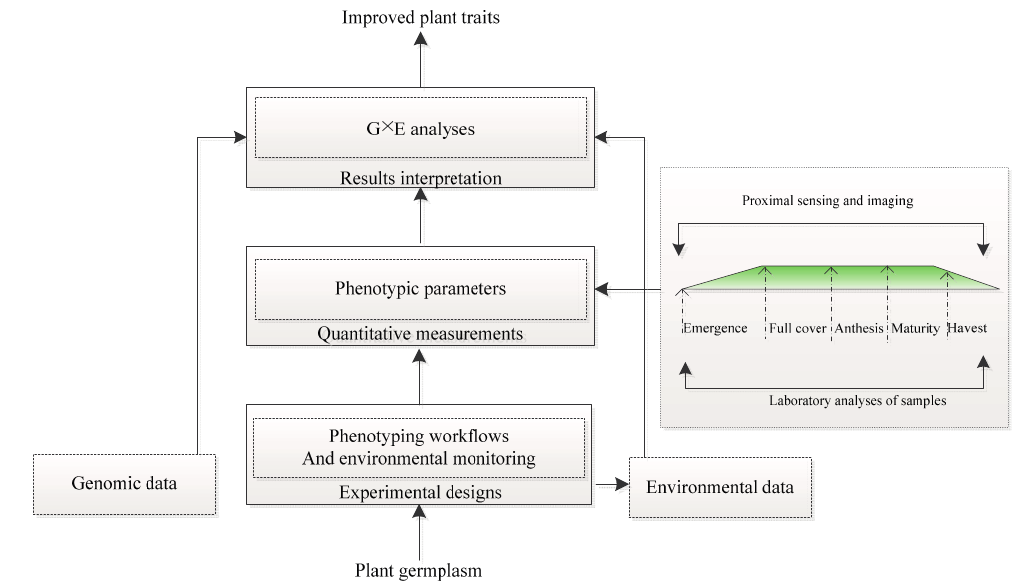
Figure 1. A scheme for plant phenotyping